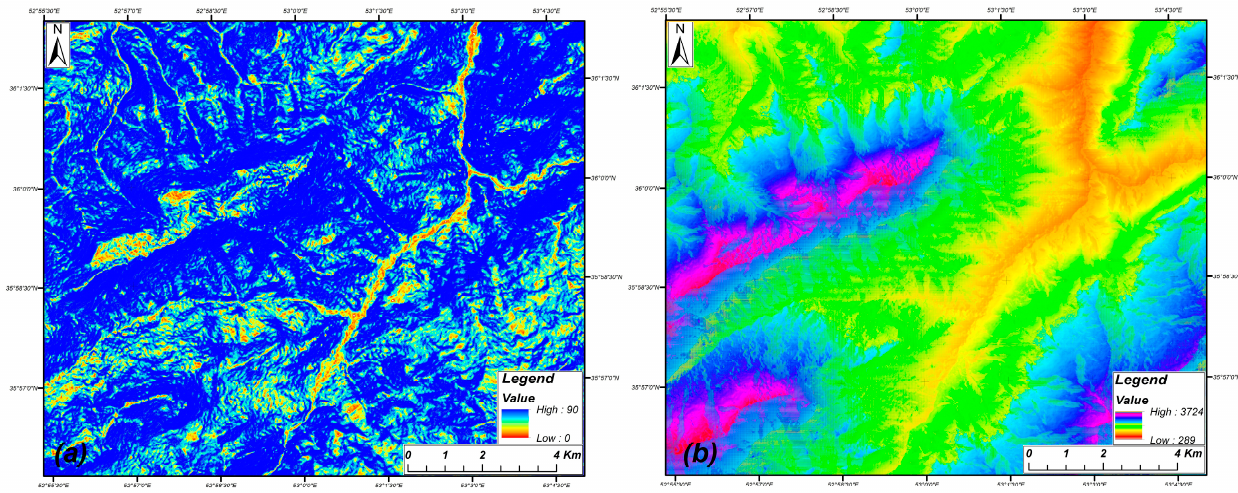
Figure 5. The water conditional triggering factors: ( a ) hydrological gradient, ( b ) drainage pattern, and ( c ) flow gradient. 3. Materials and Methods 3.1. CNN-Based Model CNNs is a deep-learning-based feed-forward neural network that is applied to the analysis of visual imagery [42]. They are neural networks that use convolution instead of general matrix multiplication in at least one of their layers, which consists of an input and an output layer, as well as multiple hidden layers [42]. The basic architecture of the ap- plied CNN algorithm is presented in Figure 6. CNN’s hidden layers typically consist of convolutional layer series that convolve with multiplication or other dot product [43]. The activation function is usually the RELU layer and is, subsequently, followed by ad- ditional convolutions, such as pooling layers, fully connected layers, and normalization layers, referred to as hidden layers because their inputs and outputs are masked by the activation function and final convolution [43]. When the evaluation reaches the end of each stage and desires to reduce the sampling, the spatial information storage capacity decreases. So, in order to keep this information, the pooling functions are utilized. The final convolution, on the other hand, frequently involves backpropagation in order to achieve a more precise weighting of the end-product. This path helps to achieve high precision in feature extraction form in visual imagery [44].